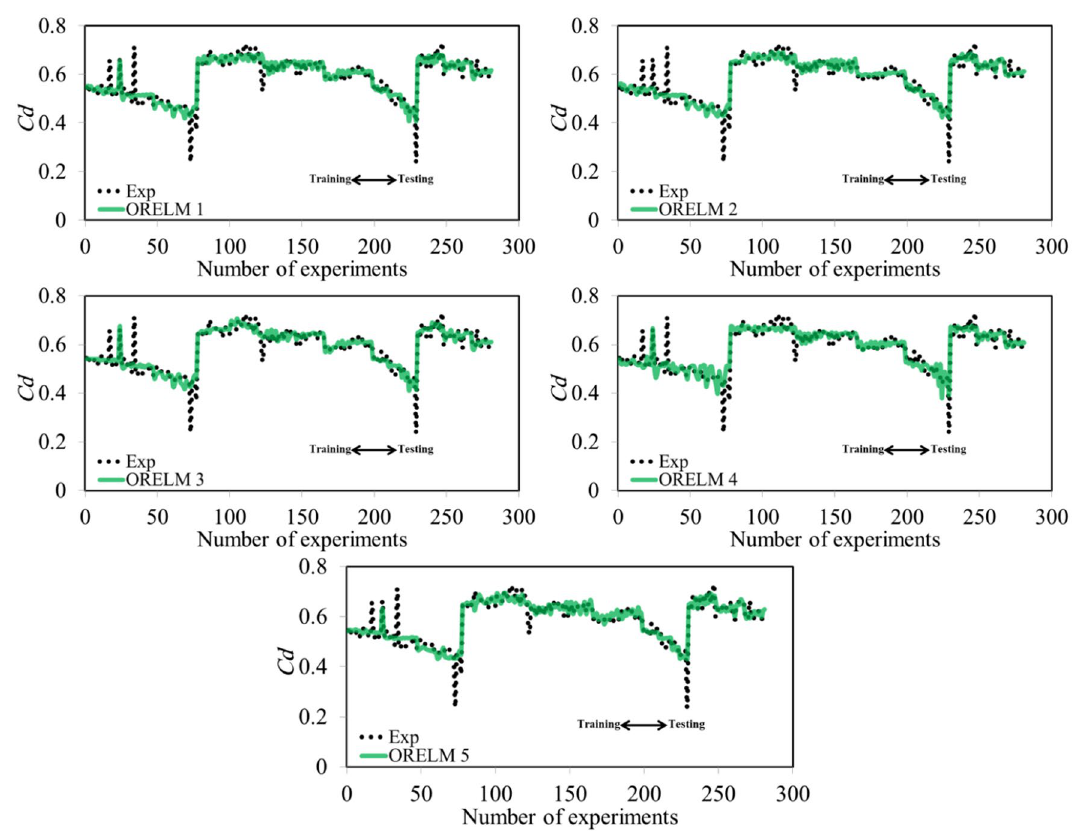
Fig. 9 Comparison of coefficient of discharge computed by ORELM models with observed data in both